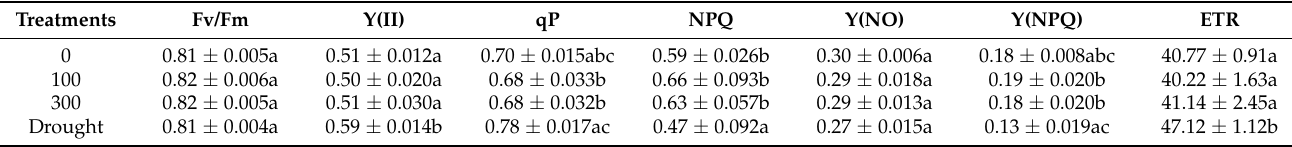
Figure 5. A-Ci curve was used to determine the following parameters: maximum rate of Rubisco carboxylase activity (V c,max ), maximum rate of electron transport (J max ), and utilization of triose phosphates (TPU) under 0, 100, and 300 mM NaCl. Different lower-case letters indicate significant differences due to salt treatments, according to Bonferroni’s test ( p < 0.05). Table 1. Chlorophyll fluorescence parameters (Fv/Fm, maximum photochemical quantum yield of PSII; Y(II), effective photochemical quantum yield of PSII; coefficient of photochemical quenching (qP); Non-photochemical quenching (NPQ) Y(NPQ), yield for heat dissipation; Y(NO), and yield of non-photochemical; and ETR, electron transport rate under saline and drought conditions. Different lower-case letters indicate significant differences due to salt treatments, according to Bonferroni’s test ( p <